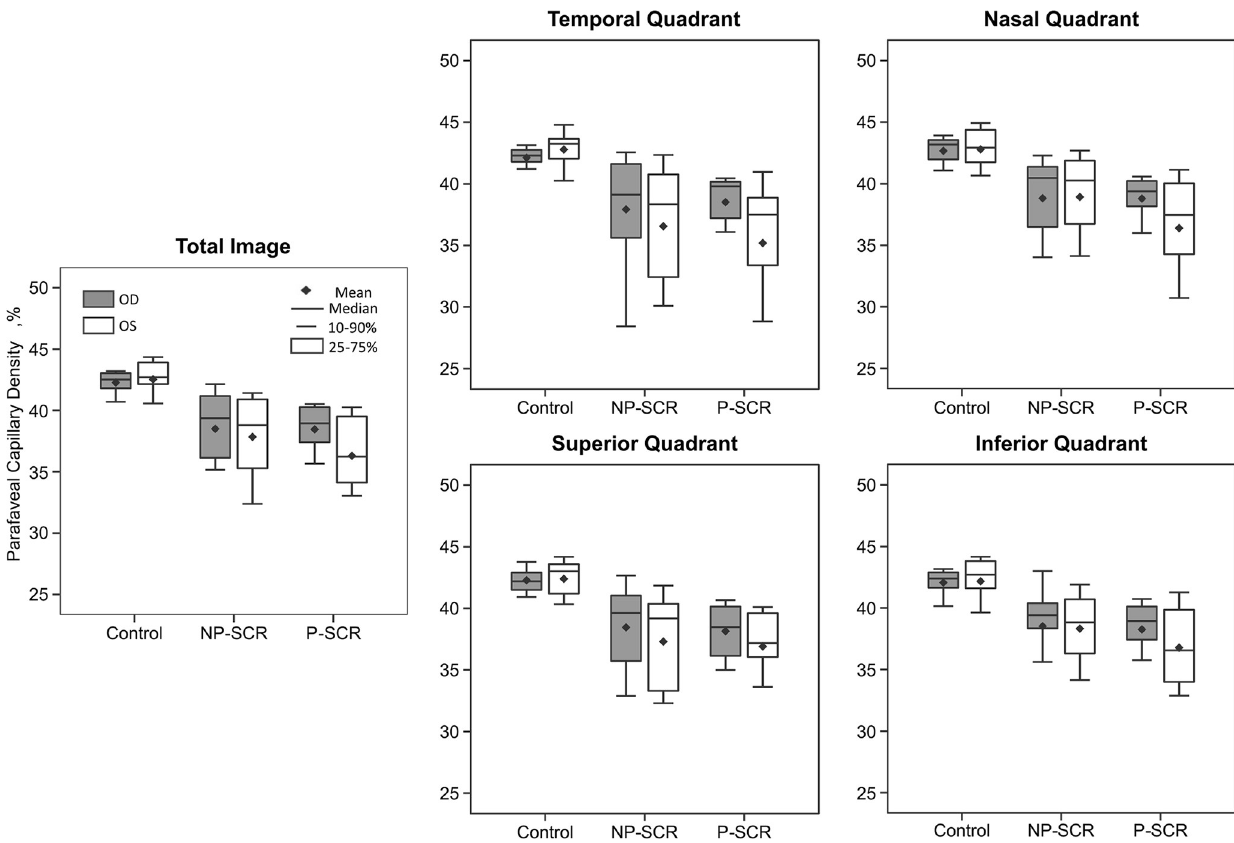
Fig 3. Boxplots of parafoveal capillary density measurements for the right and left eyes of NP-SCR, P-SCR, and unaffected controls.